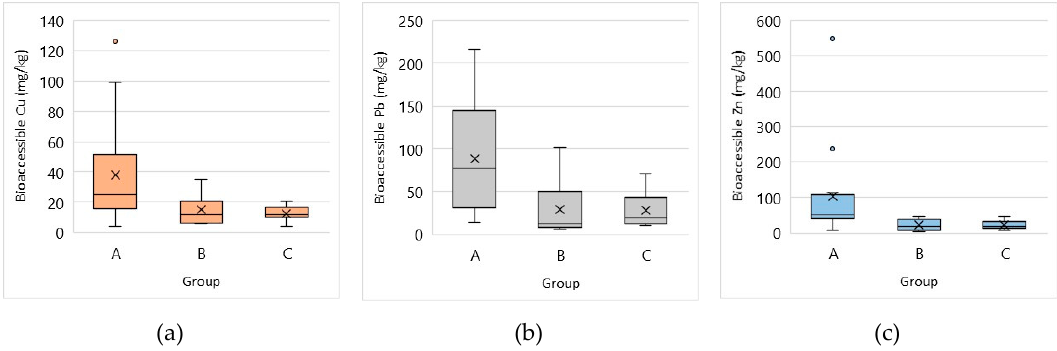
Figure 4. Variation in bioaccessible concentrations of copper ( a ), lead ( b ) and zinc ( c ) with proximity to Glasgow City Centre (A: <10 miles; B: 10–30 miles; C >30